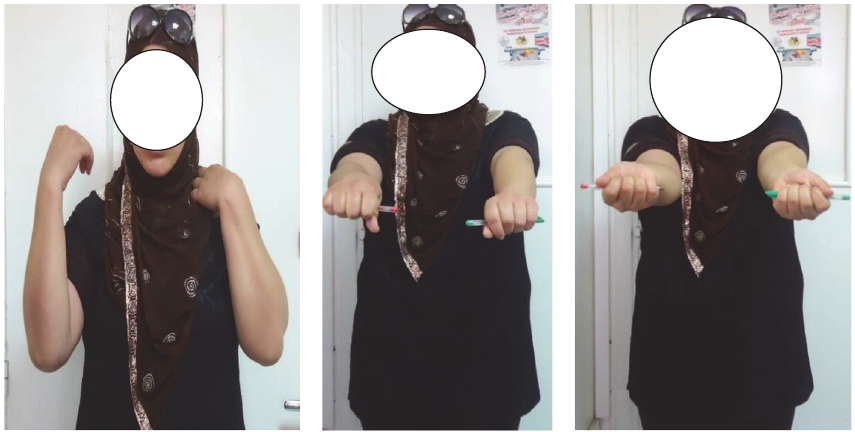
Figure 5: Recovery with excellent functional